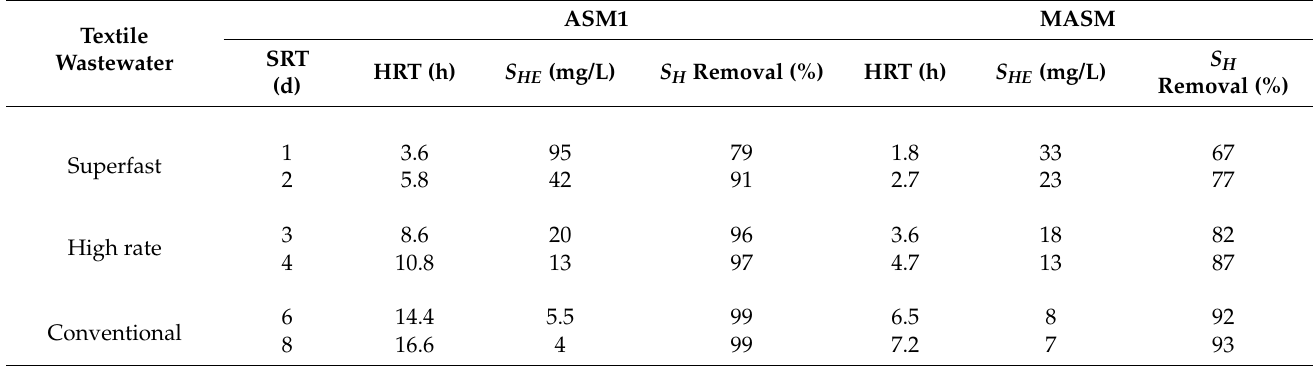
Table 4. S H removal in ASM1 and MASM models operated for different footprints (different SRTs). Textile